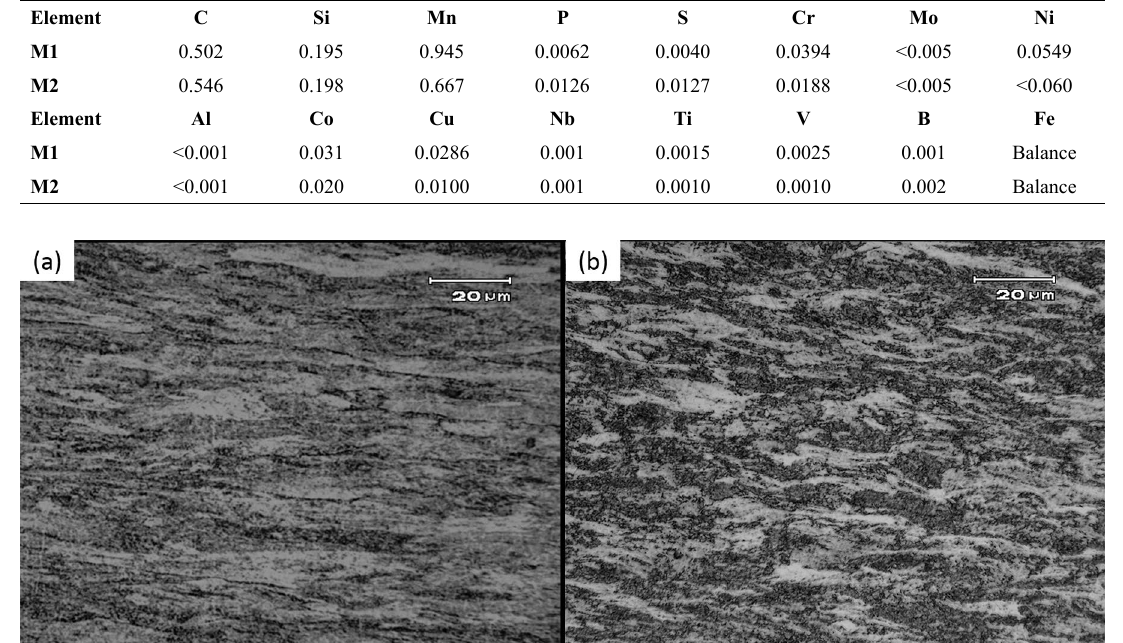
Figure 2. Microstructure of M1 material; (A) longitudinal section; (B) transversal section. Nital 2% etchant.